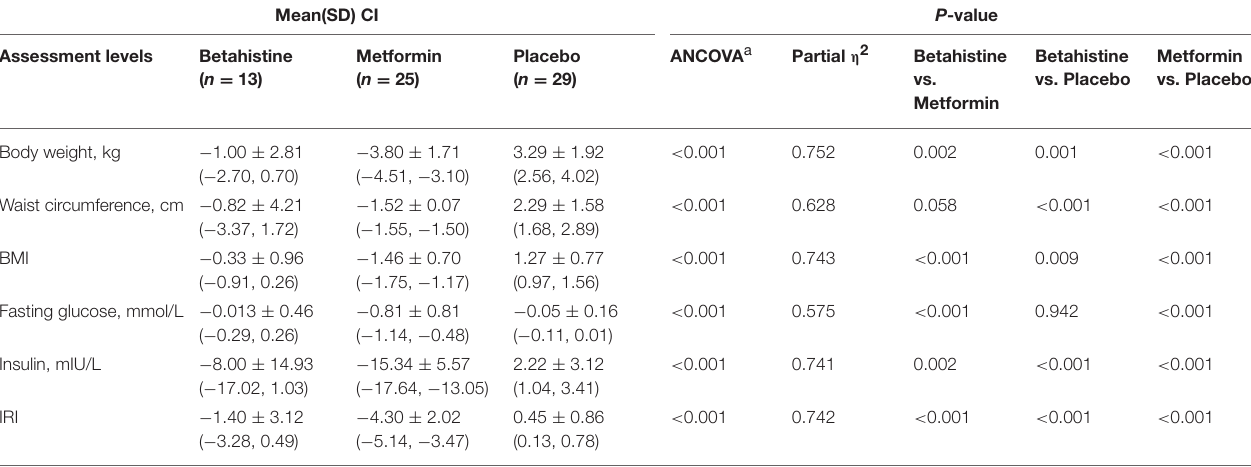
TABLE 3 | The difference between baseline and end point of all treatment outcomes.